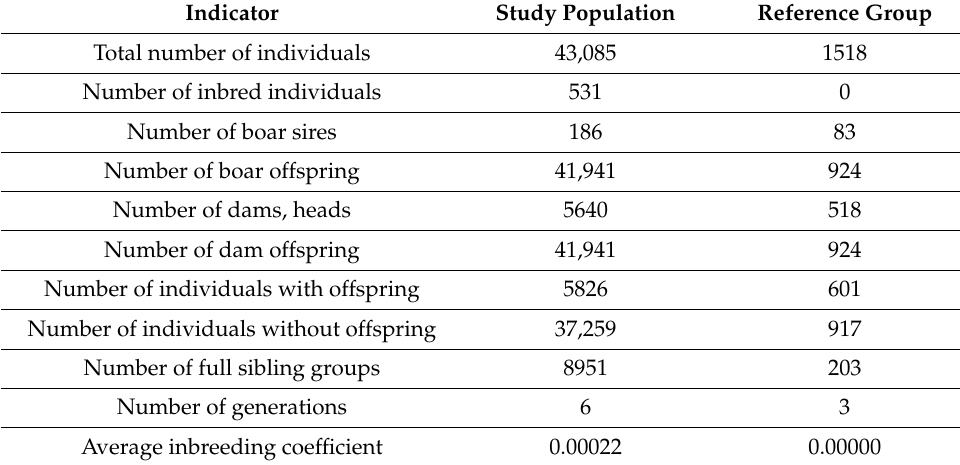
Table 2. The structure of the pedigrees of the analyzed groups of